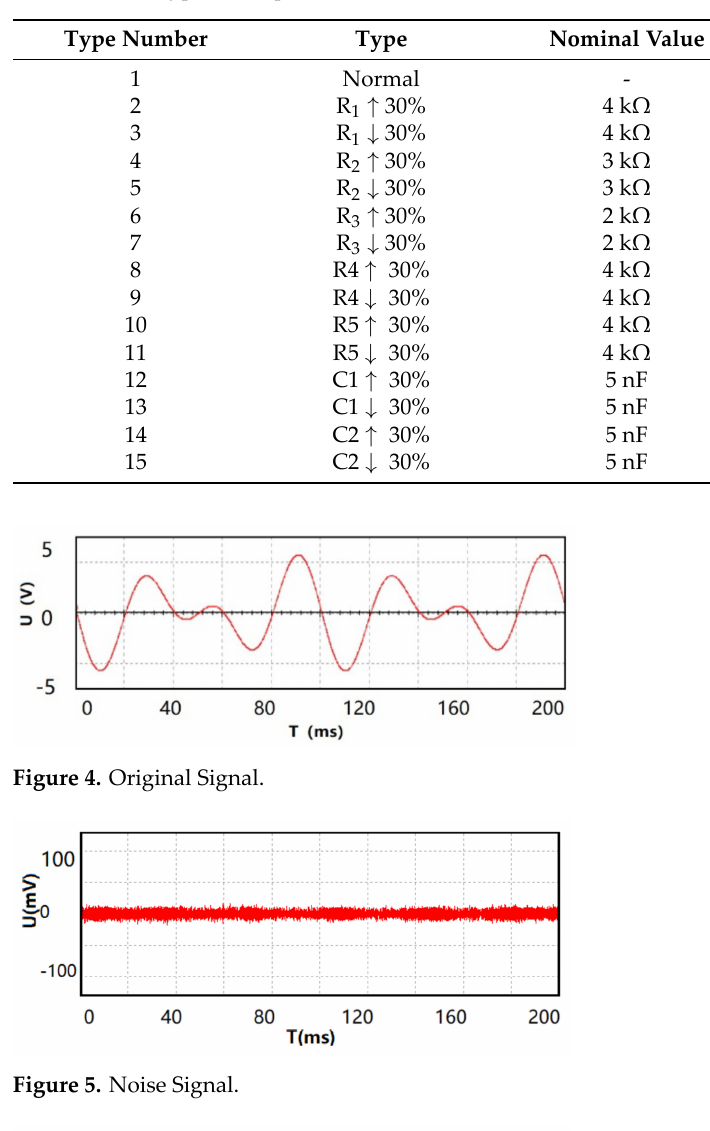
Table 1. Fault Type Description.